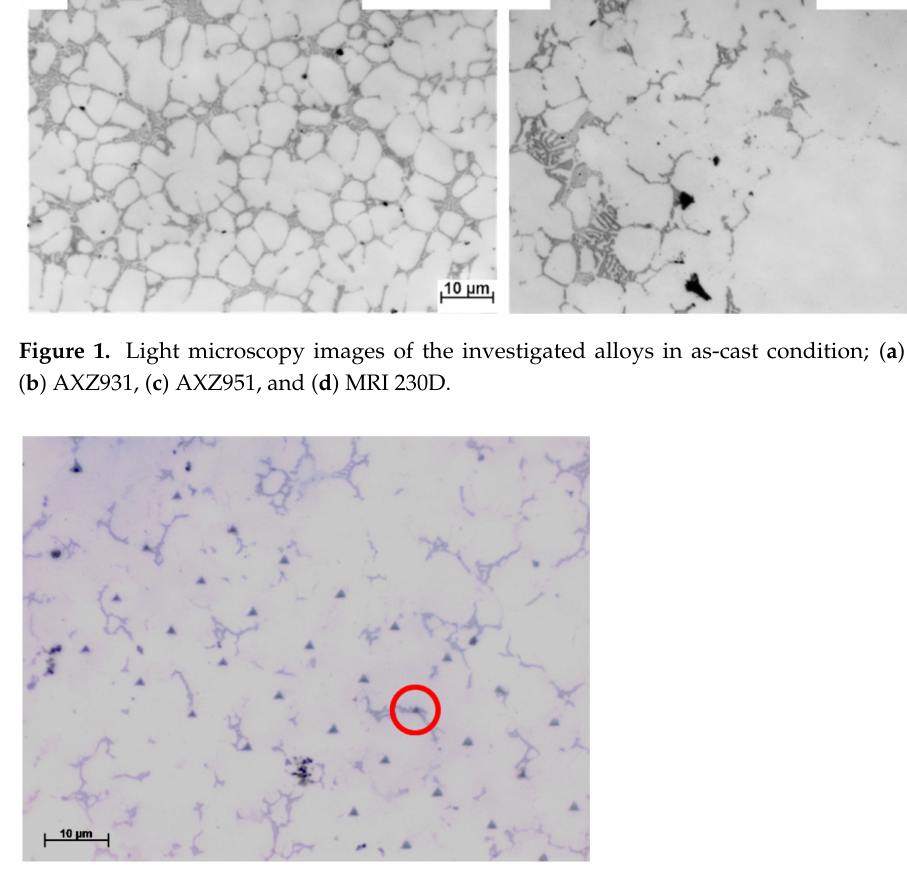
Figure 2. Light microscopy image of the indents in a sample of the alloy AXZ911; the red circle exemplarily marks an indent in the